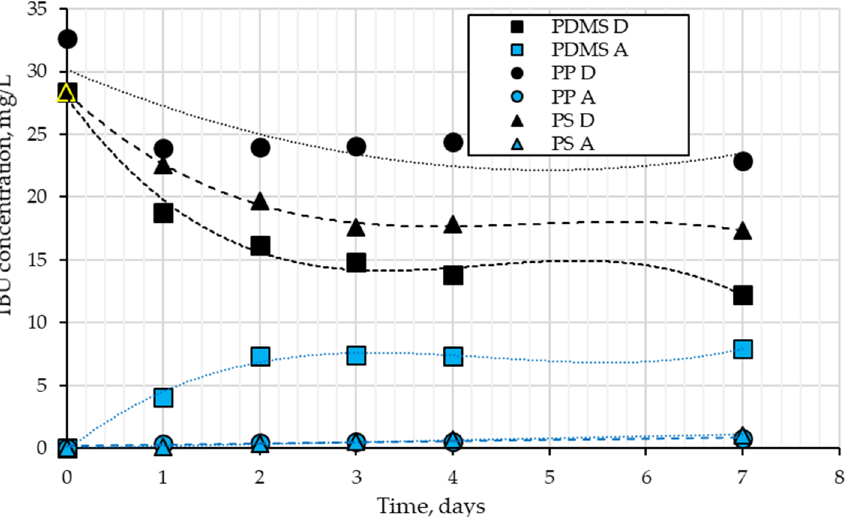
Figure 9. IBU concentration in donor (D) and acceptor (A) solutions during pertraction by PDMS, PS, and PP membranes.